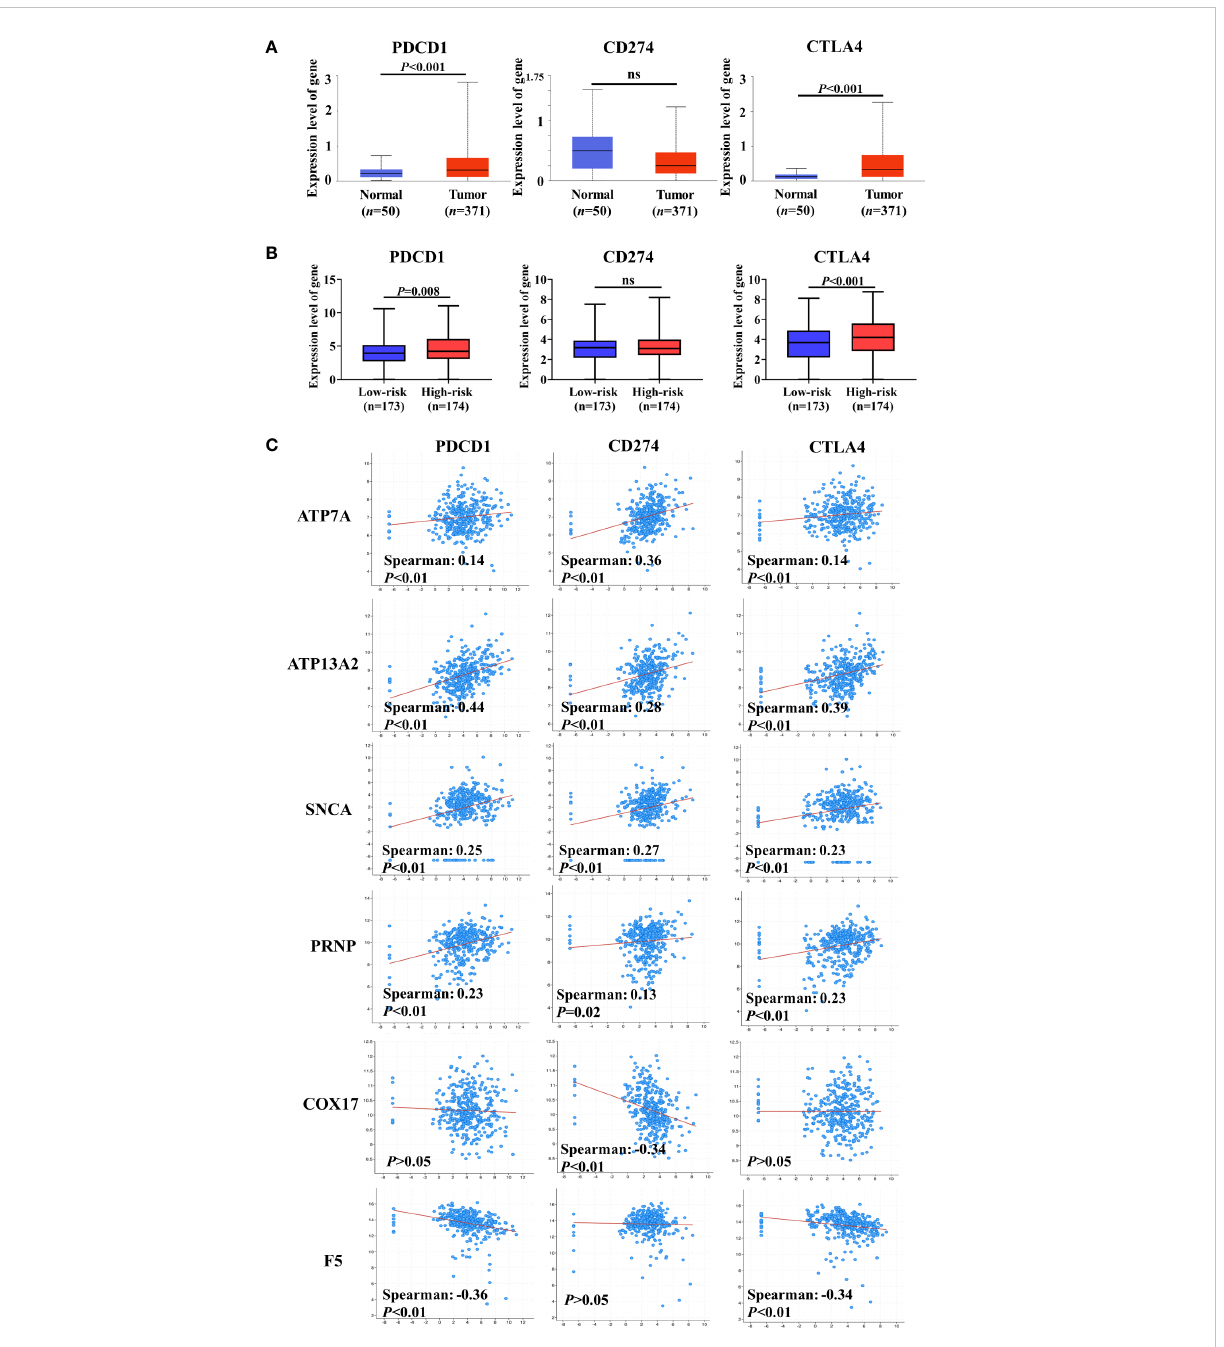
FIGURE 6 Co-expression analysis of cuproptosis-related genes (CRGs) and immune checkpoint genes (ICGs). (A) Expression levels of ICGs between normal liver tissue and hepatocellular carcinoma (HCC). (B) Differences in the expression of ICGs between low-risk and high-risk groups. (C) Co-expression analysis of CRGs and ICGs. ATP7A, ATP13A2, and SNCA were signi fi cantly positively correlated with the expression of ICGs, and a negative correlation between ICGs and COX17 or F5 was observed. ns, no signi fi